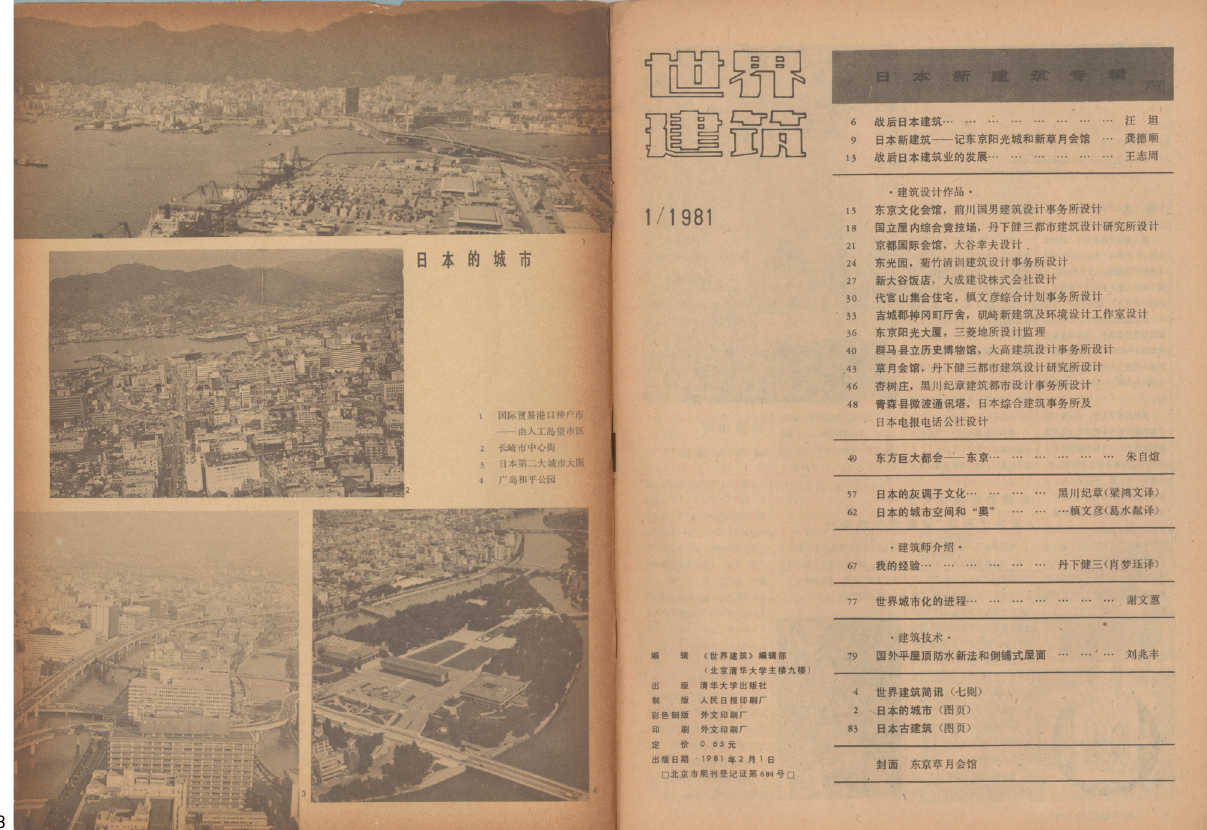
Shìjiè Jiànzhú ’s special issue on new Japanese architecture, 1981, no.